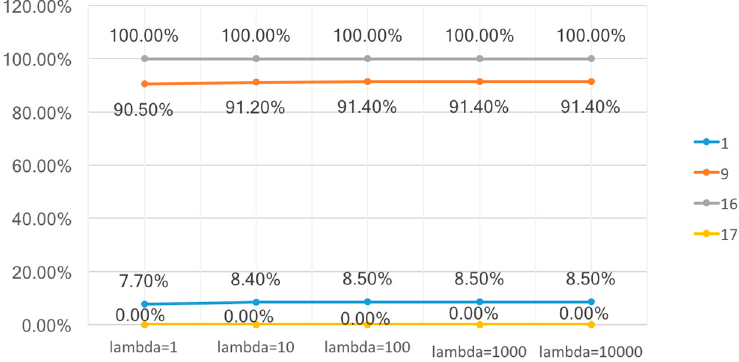
Figure 14. The influence of λ .